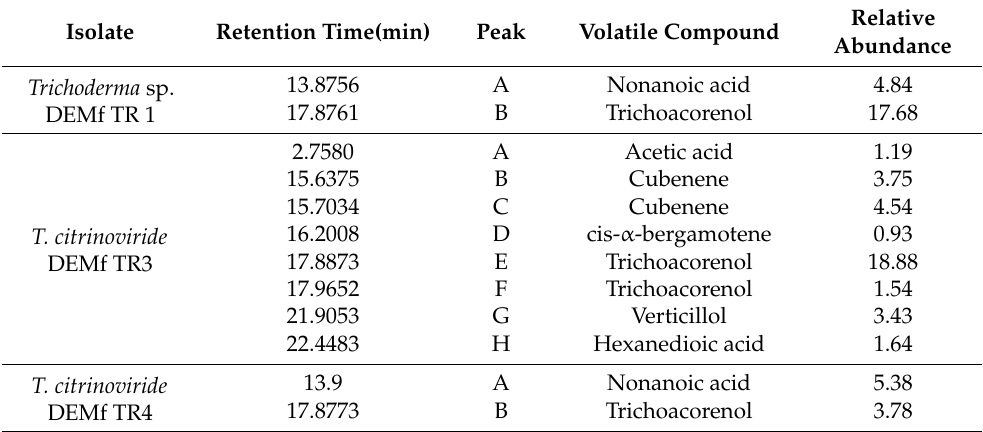
Table 4. VOCs emitted by Trichoderma sp. DEMf TR1, T. citrinoviride DEMf TR3 and T. citrinoviride DEMf TR4 identified by